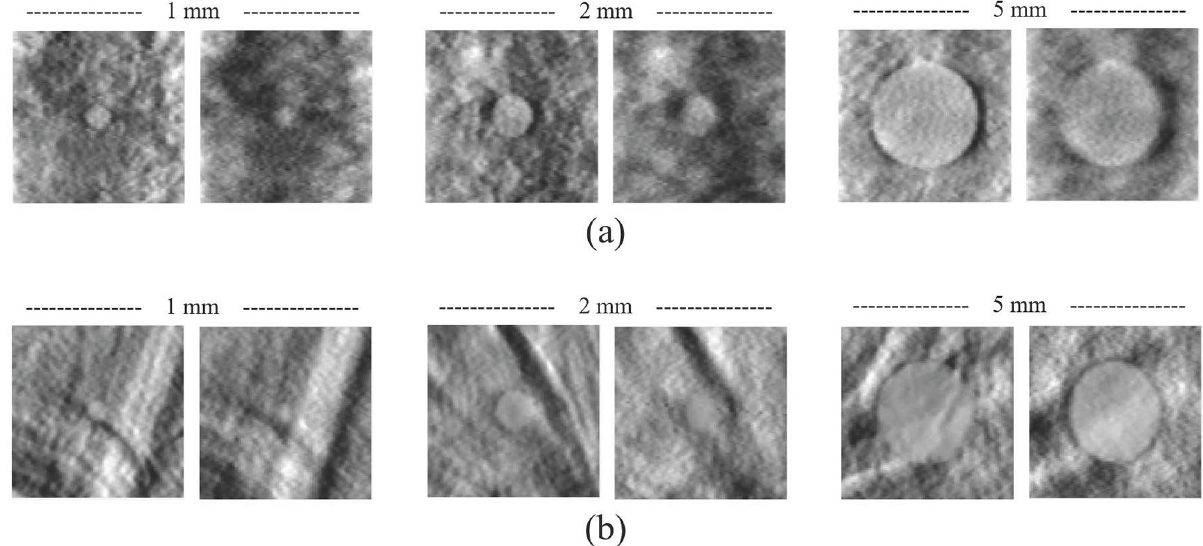
Fig 10. Examples of reconstructed images with spherical signals from (a) simulated breast phantom and (b) BR3D breast phantom. In each image set, the left image was obtained in step-and-shoot mode, and the right image was obtained in continuous mode. The display window is set by [min. max.] mm − 1 to visualize the background structures more